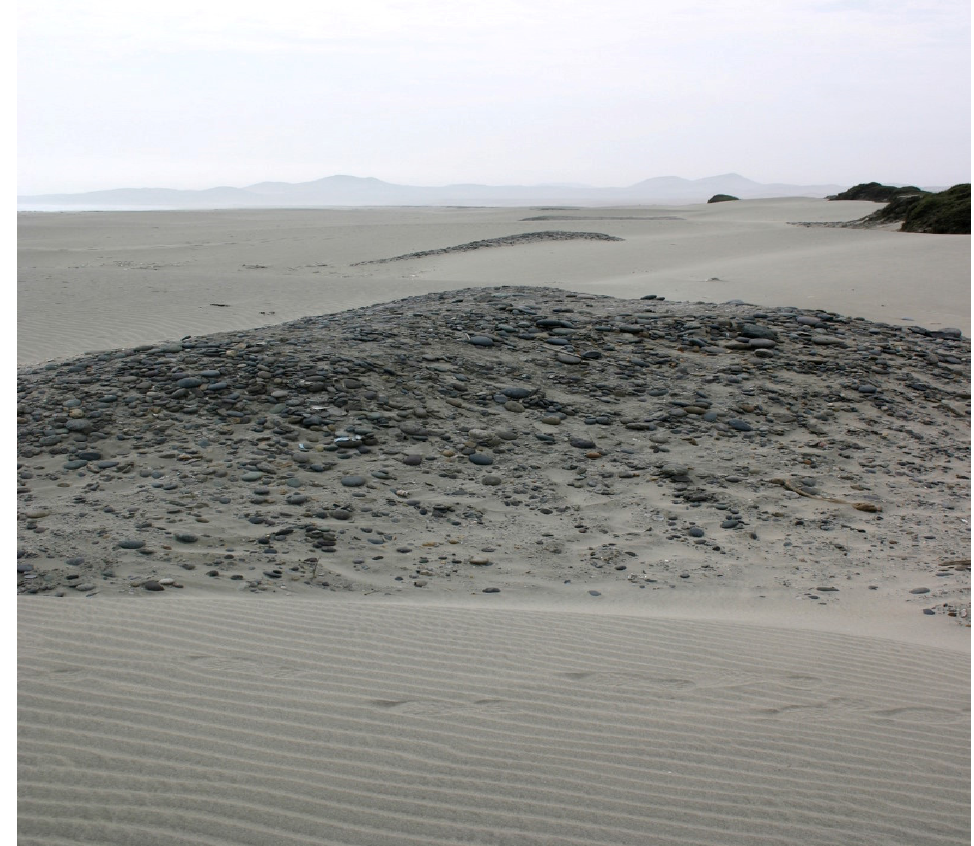
Figure 18. A further early coastal ancient linear beach ridge, now partially covered by aeolian sand drifts; further stranded beach ridges are to be found closer to the shoreline resulting from later El Niño flood events. Ongoing tectonic uplift helps to strand and separate a sequence of beach ridges.